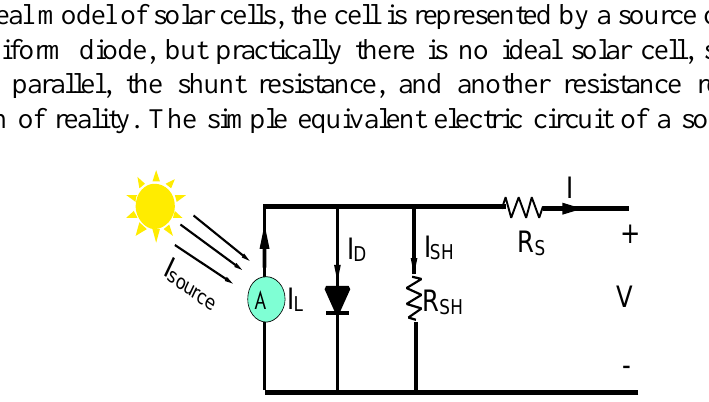
Fig.1. Single-diode electrical equivalent circuit model of a solar